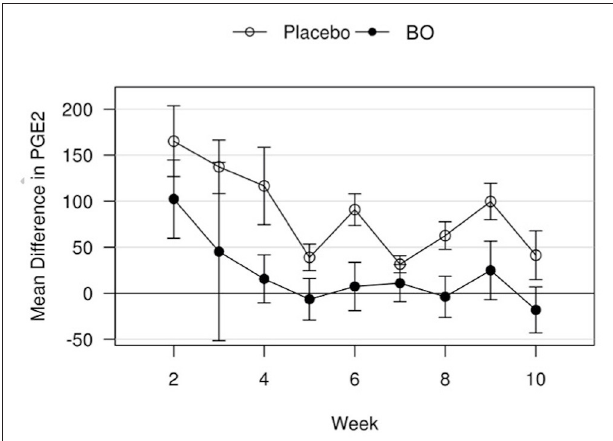
FIGURE 4 | Mean differences in PGE2 values for placebo and BO treated horses. Measurements are in terms of changes from baseline. Values were also adjusted to accommodate the values of the sham operated joint, such that the means represented here are based on the following equation: d i , t = (cid:0) x i , OA , t − x i , sham , t (cid:1) − (cid:0) x i , OA , base − x i , sham , base (cid:1) . A significant difference (p = 0.043) was found when evaluating across all time points, but no single time point was significantly different. Error bars represent + /- 1 standard error. Units are pg/mL.